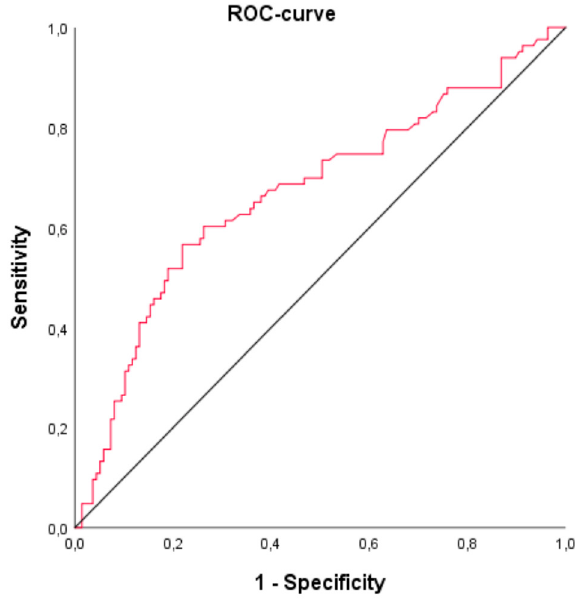
Figure 2. ROC and AUC for bilirubin on day 5 of ECLS therapy as a discriminator for mortality, excluding shock liver patients ( n = 220). AUC = 0.67 (95% confidence interval (CI): 0.59–0.75). The Youden index showed a cutoff for bilirubin on day 5 of 2.23 mg/dl, with a sensitivity of 0.70. Cox regression with multivariable adjustment revealed a significant association between bilirubin on day 5 and mortality, with a hazard ratio (HR) of 2.24 (95% CI: 1.53–3.30) (see Table 2 and Figure 3).